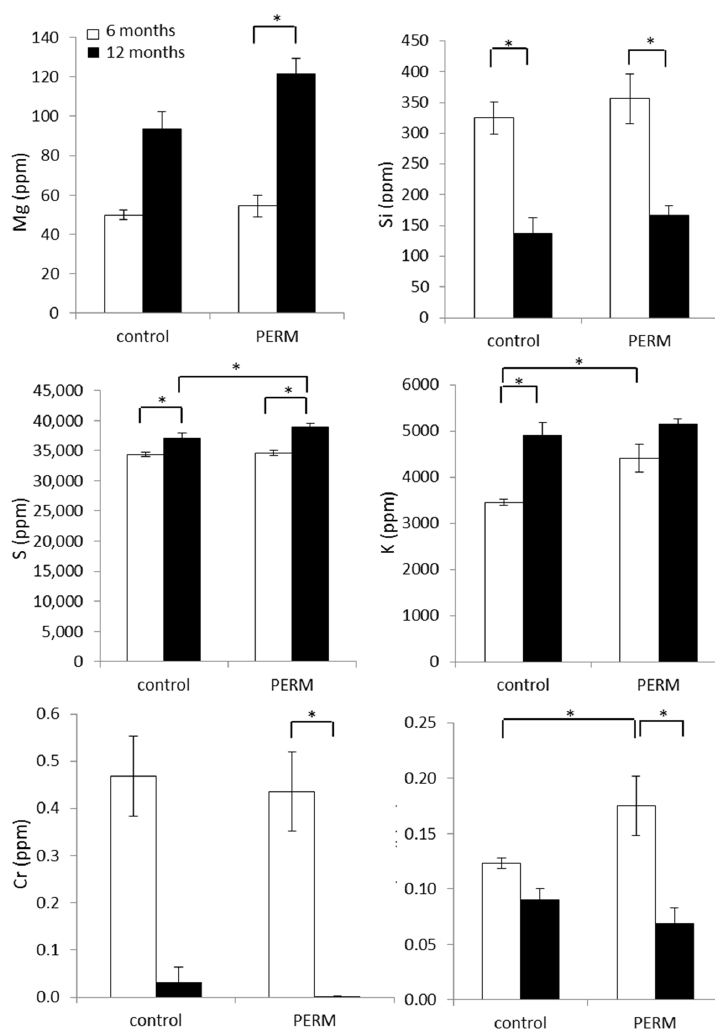
Figure 3. Analysis of microelements in hair from early life Permethrin (PERM)-treated rats and control ones at six and 12 months of age. Data are expressed as the mean values ± SEM. * p < 0.05. Toxics 2016 , 4 , 3 PCA analysis on metals and microelements that were significantly changed showed two clusters (Figure 4). In particular, the variable factor map indicates that PC1 (Dim1) was correlated with all microelements except Cu. All microelements on the right of the picture were negatively correlated with those in the left of the map, except for Cu, associated with PC2 (Dim2), which was negatively correlated with Ca.